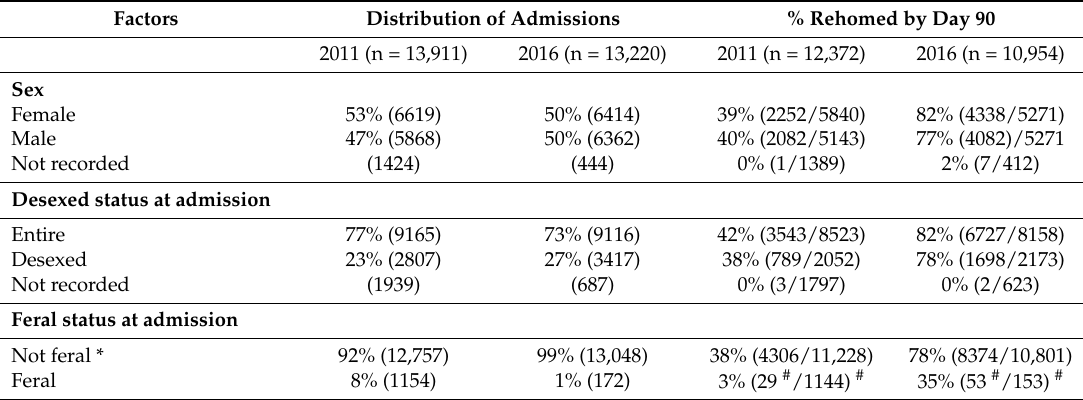
Table 2. Numbers of cat admissions into RSPCA Queensland shelters by sex, desexed status, and feral status (n = 13,911 and 13,220 in 2011 and 2016, respectively) and percentages of those admissions in which the cat was rehomed by day 90 for admissions in which the cat was available to be rehomed (n = 12,372 and 10,954 in 2011 and 2016, respectively).